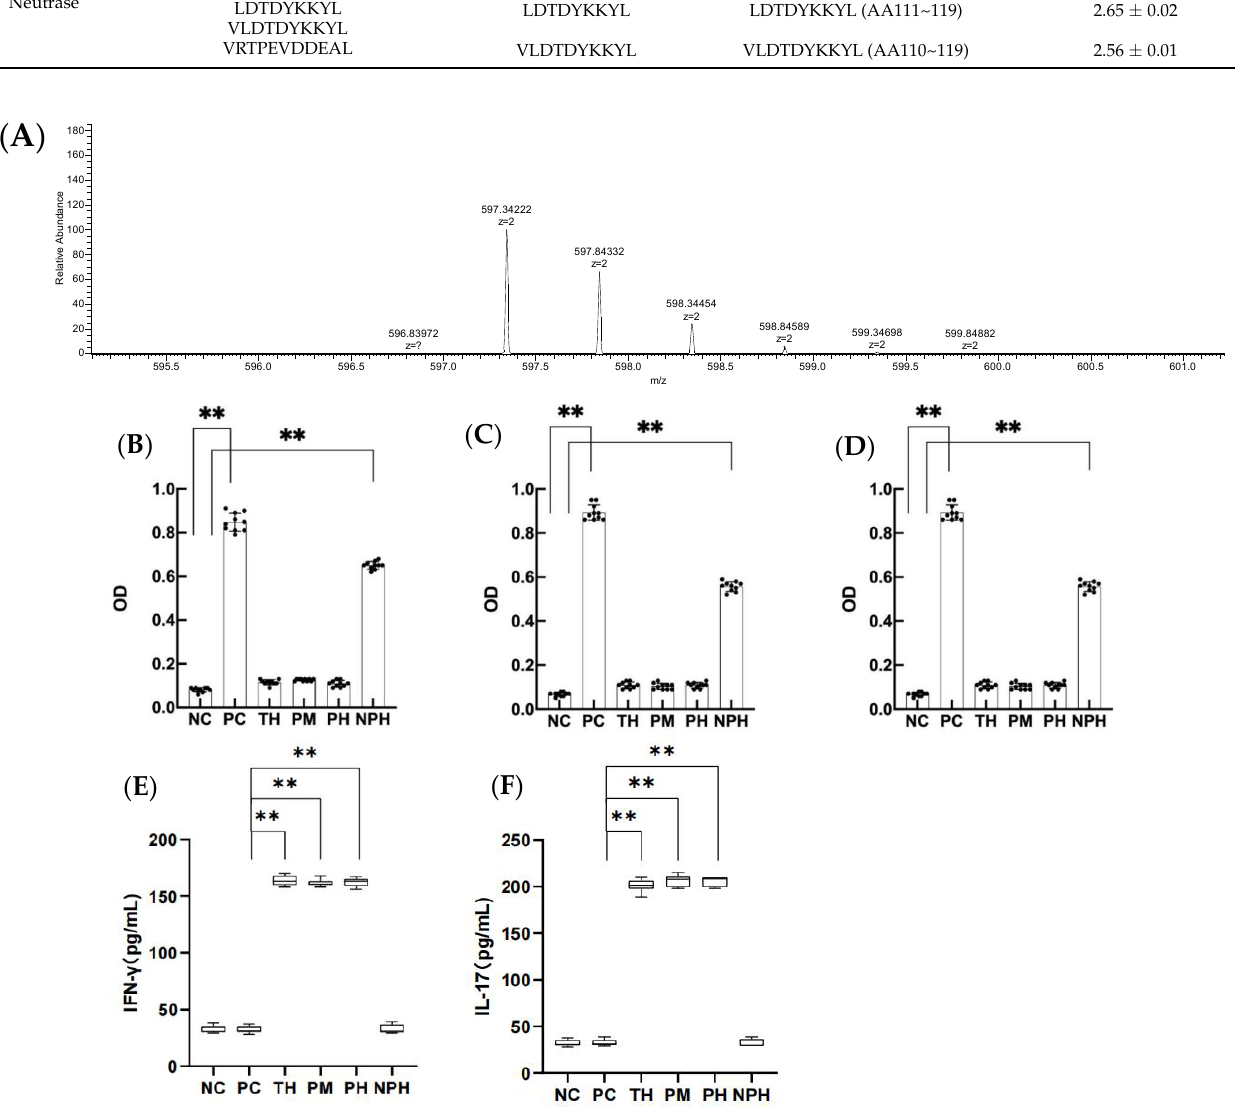
Figure 1. The primary mass spectra of DEALEKFDKALKALPMHIRLS peptide, ( A ) levels of specific IgE, IgG 1 and IgG 2a in the serum of mice in each group ( B – D ) and contents of IFN-γ and IL-17 in the mice of each group (E,F). ( B ) corresponds to the level of specific IgE; ( C ) corresponds to the level of specific IgG 1 ; ( D ) corresponds to the level of specific IgG 2a ; ( E ) corresponds to the level of IFN-γ; ( F ) corresponds to the level of IL-17. Data are shown as the mean ± SEM (n = 10). Each dot represents an individual mouse. ** means differs significantly ( p < 0.05). NC corresponds to normal saline negative control group; PC corresponds to β-lactoglobulin positive control group; TH corresponds to trypsin hydrolysate group; PM corresponds to protamex hydrolysate group; PH corresponds to papain hydrolysate group; NPH corresponds to neutrase protease hydrolysate group. Table 1. Amino acid sequence of β-lactoglobulin hydrolysate peptides and identification of T cell epitopes.